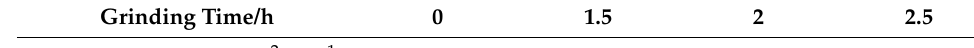
Table 3. Specific surface area of IOTs at different grinding times.